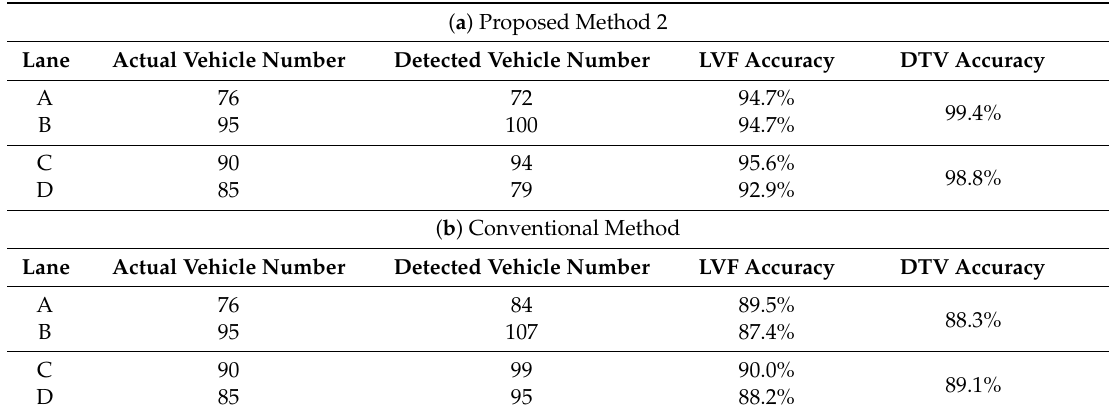
Table 4. Results of LVF and DTV detection during 8:30–8:40 AM (rush-hour traffic) using ( a ) proposed method 2 and ( b ) conventional method.